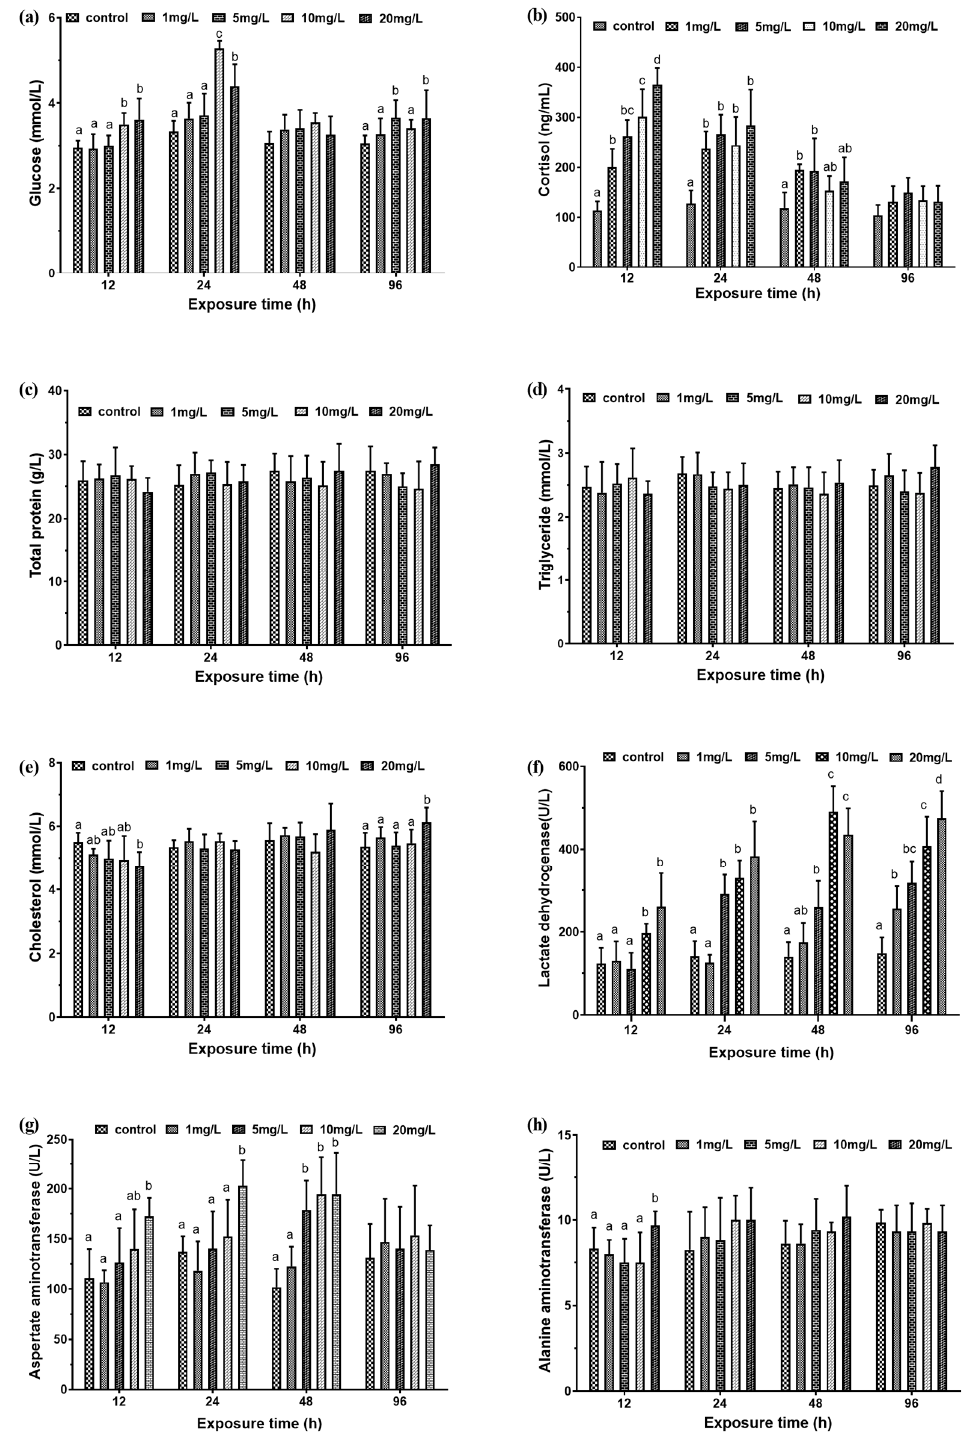
Figure 1. Serum biochemical index of M. amblycephala juveniles exposed to different nitrite concentration form 12 h to 96 h. Data are expressed as mean ± SD (n = 3). ( a ) Glucose concentration; ( b ) cortisol concentration; ( c ) total protein concentration; ( d ) triglyceride concentration; ( e ) total cholesterol concentration; ( f ) lactate dehydrogenase activity; ( g ) aspartate aminotransferase activity; ( h ) alanine aminotransferase activity. Different letters represent significant differences among treatments ( p < 0.05).